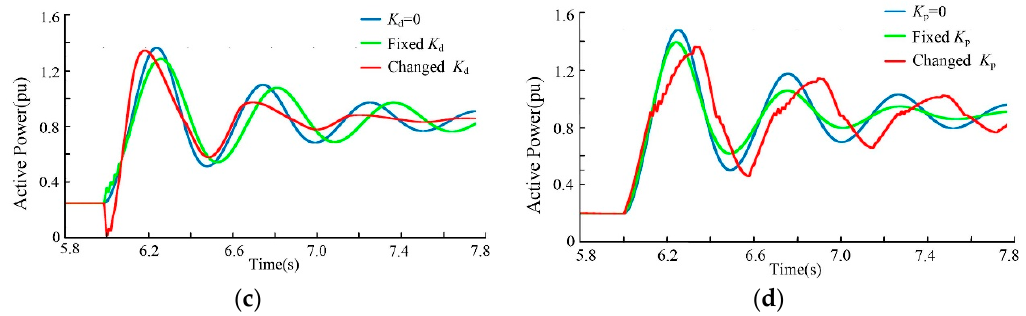
Figure 9. Independent action of damping control and inertia control. ( a ) frequency with D controller; ( b ) frequency with P controller; ( c ) SG power with D controller; ( d ) SG power with P controller.